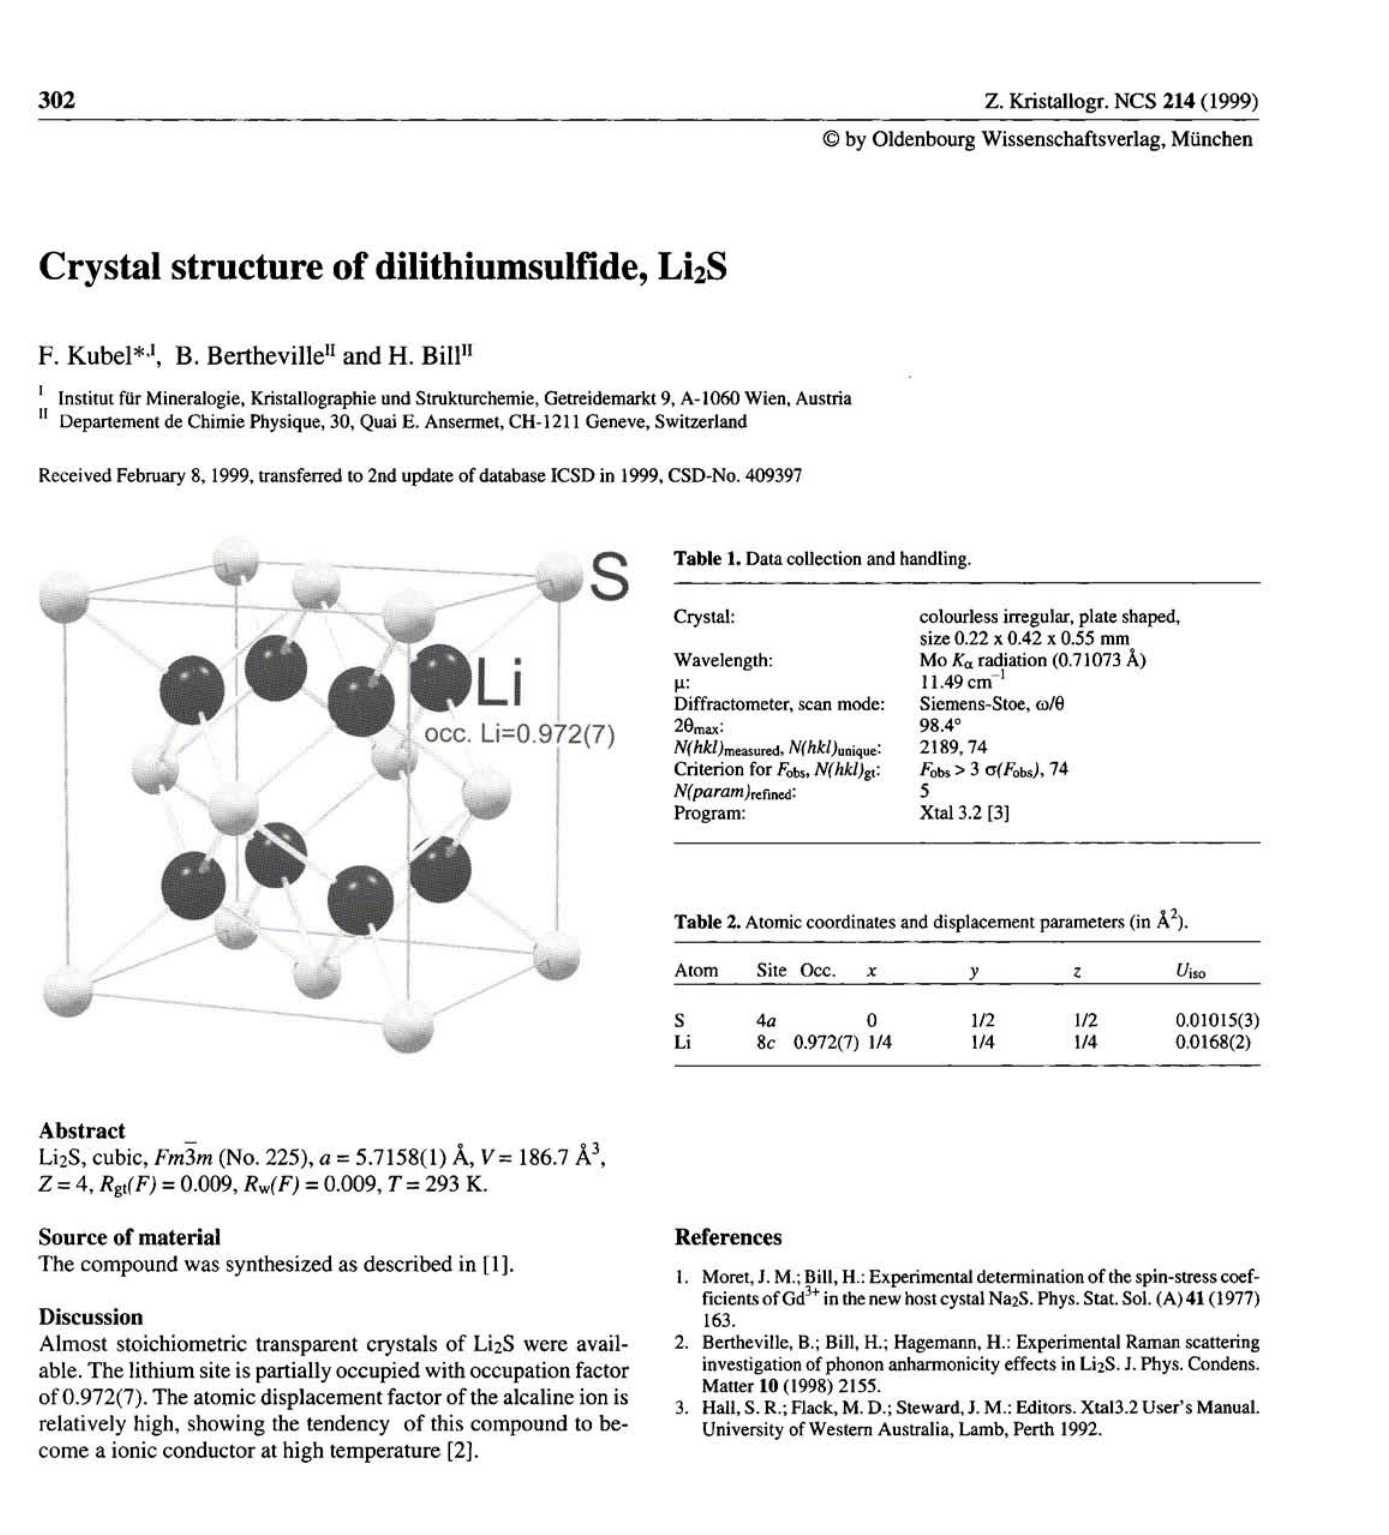
Table 2. Atomic coordinates and displacement parameters (in Â 2